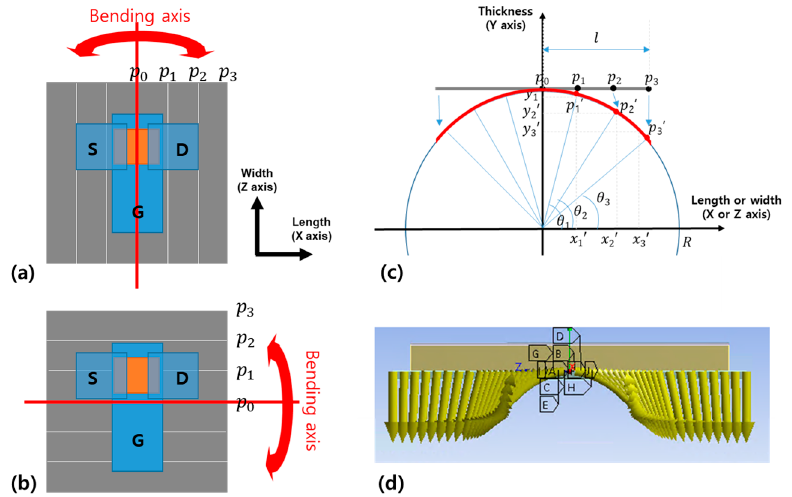
Figure 2. ( a ) Division of metal plate for applying perpendicular bending and ( b ) parallel bending to a-IGZO TFT. ( c ) Method for converting bending radius to displacement and ( d ) symmetrical displacement components used in ANSYS simulation.